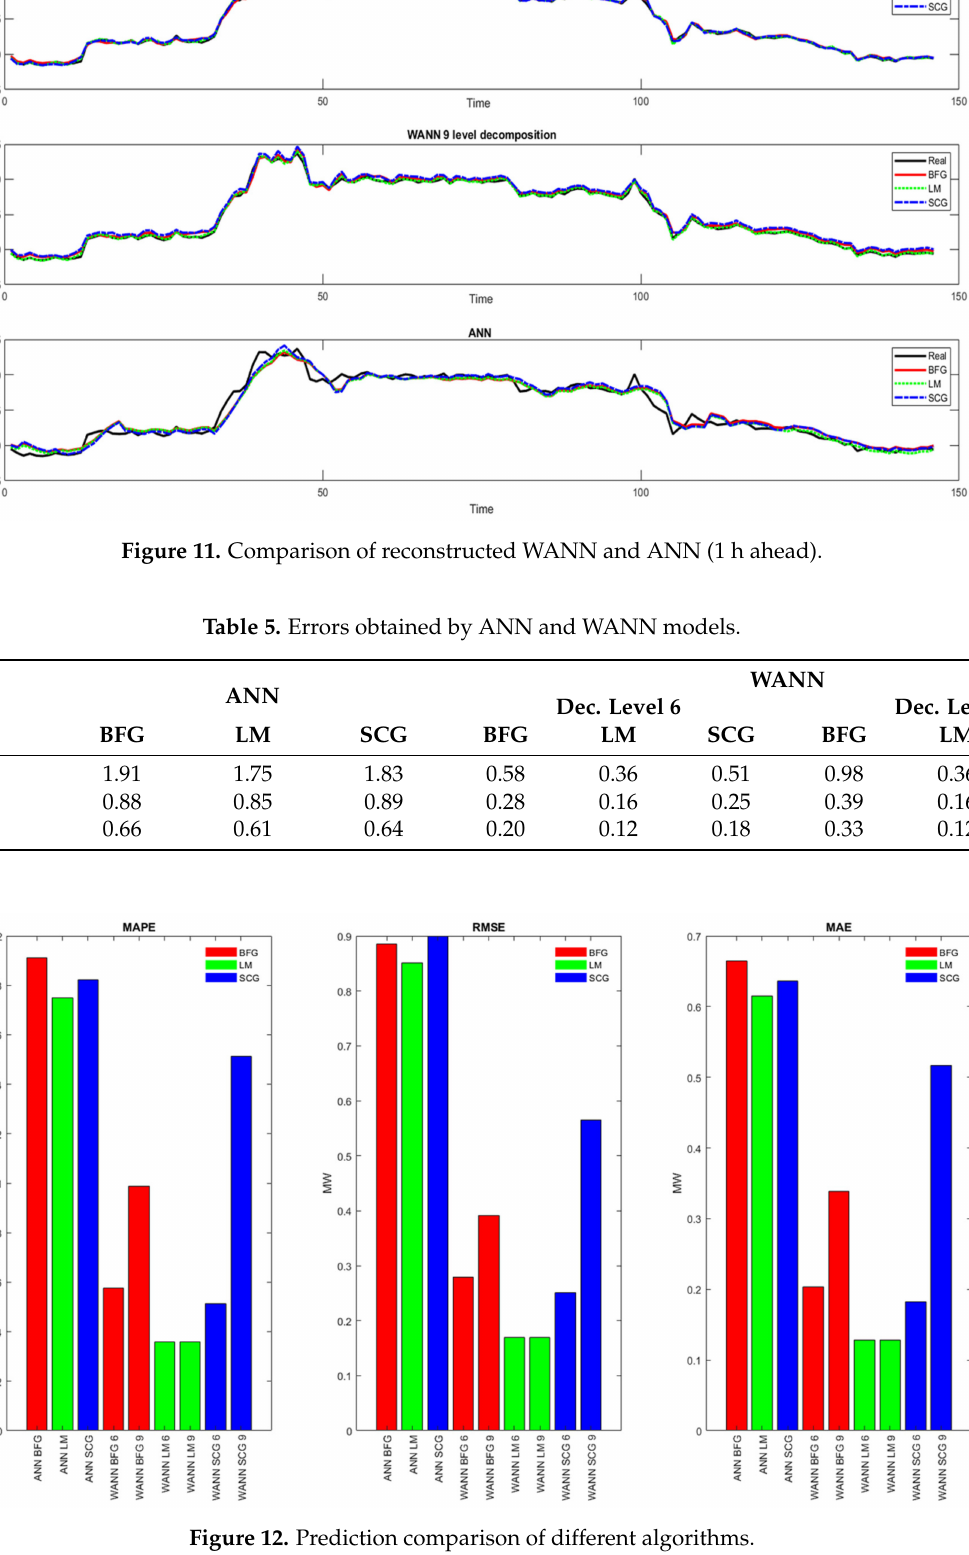
Figure 12. Prediction comparison of different